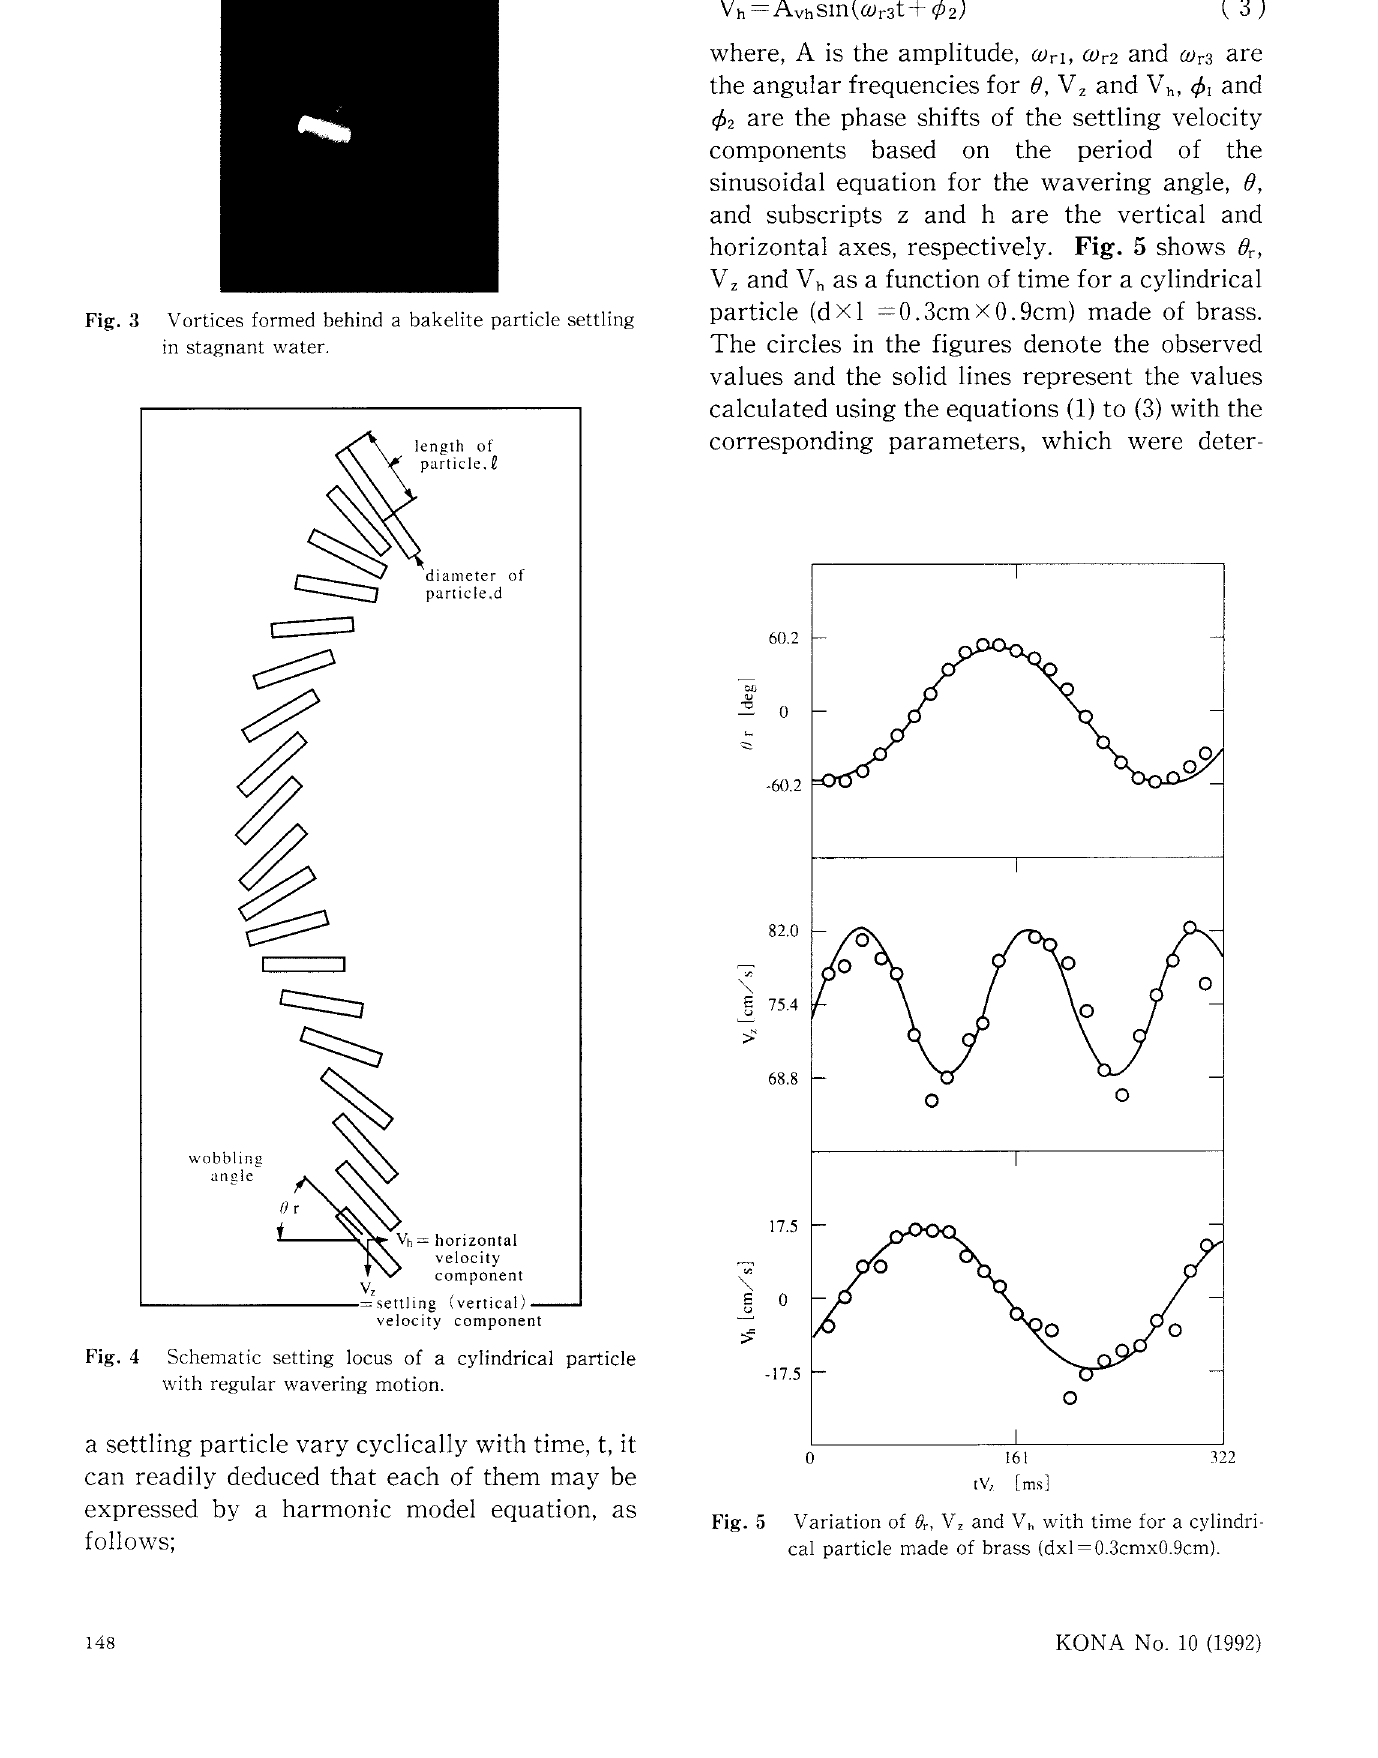
Fig. 4 Schematic setting locus of a cylindrical particle with regular wavering motion.